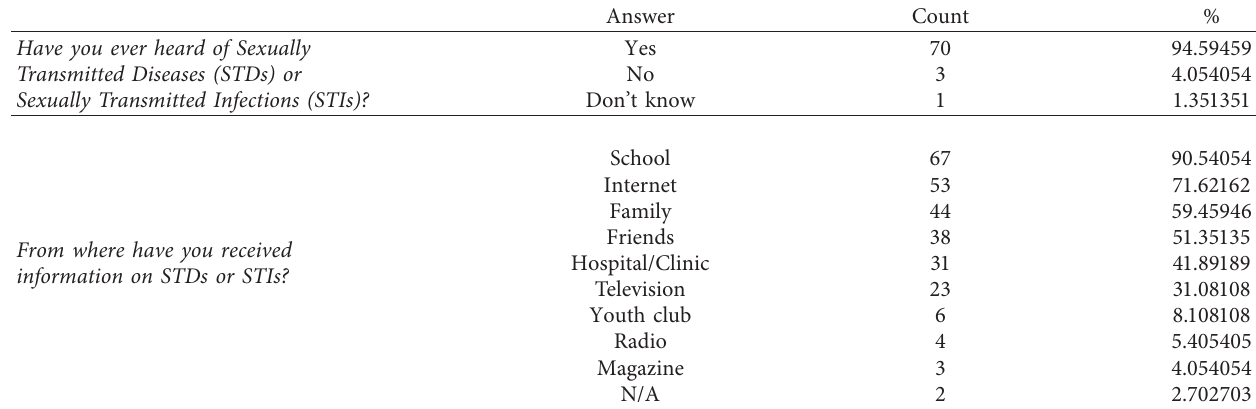
Table 2: Prior STD and STI knowledge.